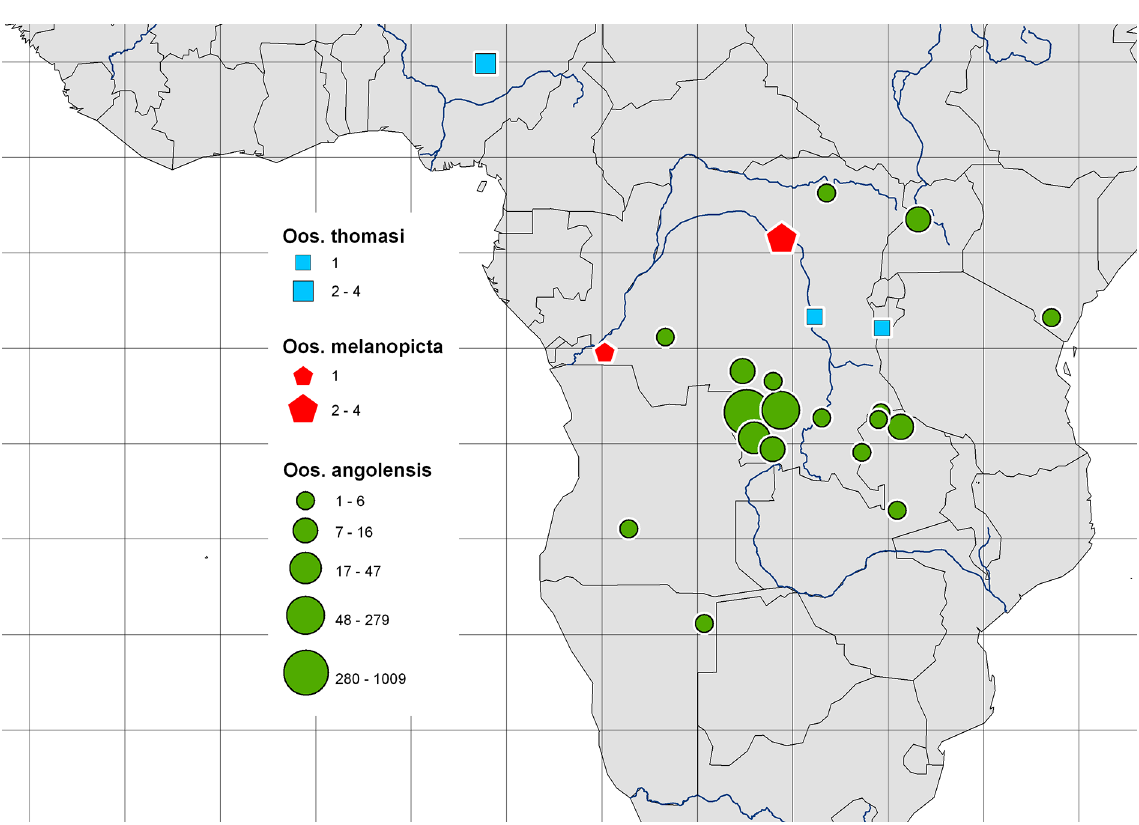
Fig. 8. Distribution of O. angolensis comb. nov., O. melanopicta sp. nov. and O. thomasi sp. nov.